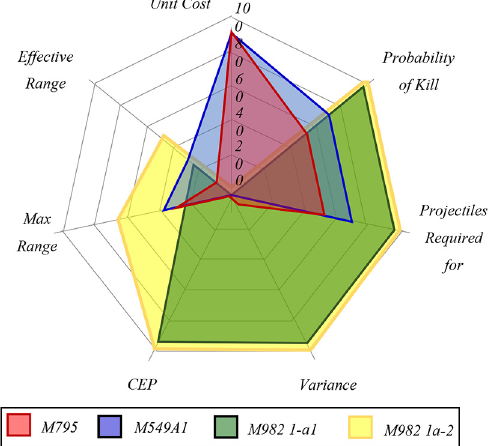
Figure 11. Value measure scores of current 155mm (total area represents the total value of the projectile)